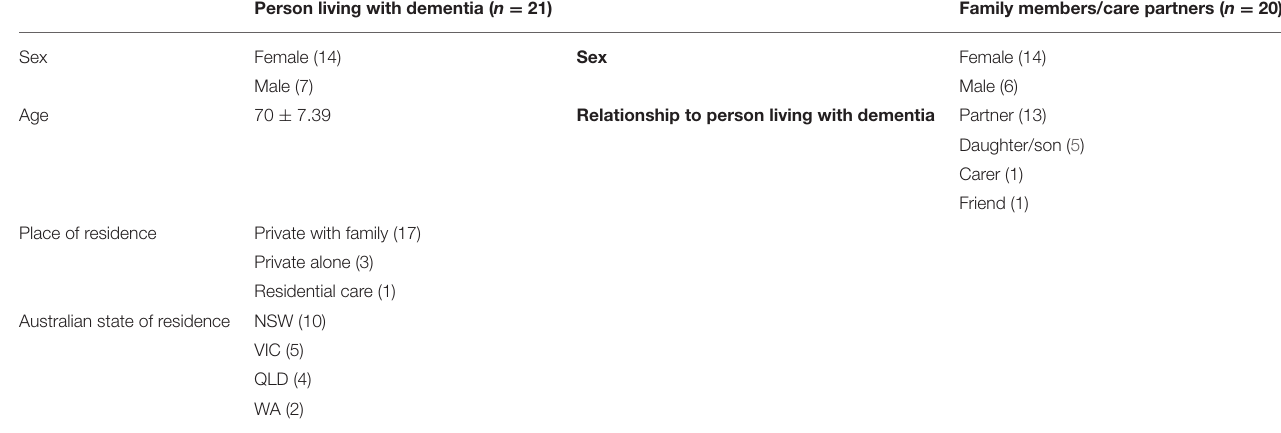
TABLE 1 | Participant characteristics.